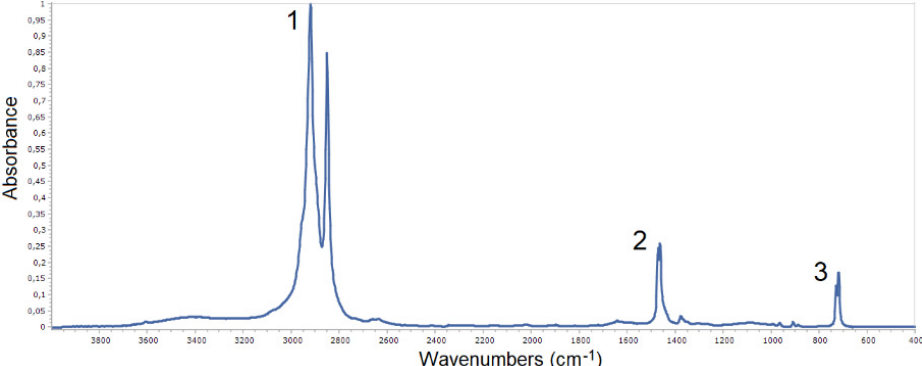
Figure 6. Wax—FTIR spectrum (normalized).